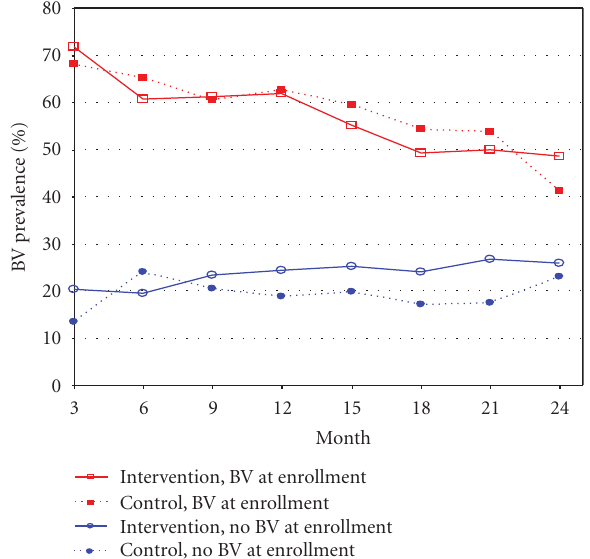
Figure 2: Intent-to-treat (ITT) analysis of percent of subjects diagnosed with bacterial vaginosis (BV) during followup among participants randomized to the intervention and control arms stratified by presence or absence of BV at